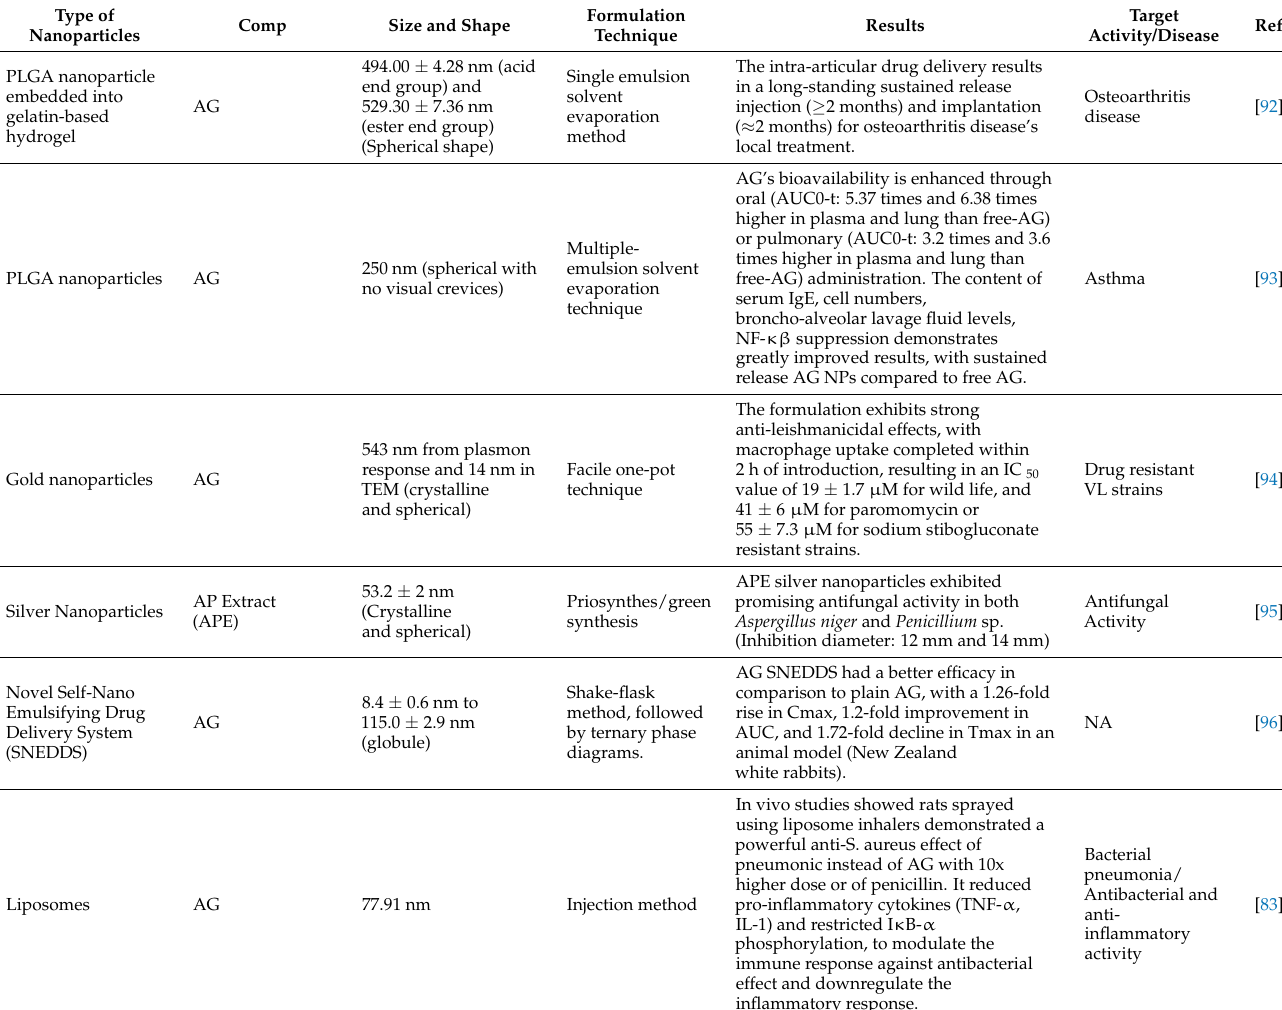
Table 1. Types of nanoparticle formulations and their pharmacological and pharmaceutics studies, with their biological